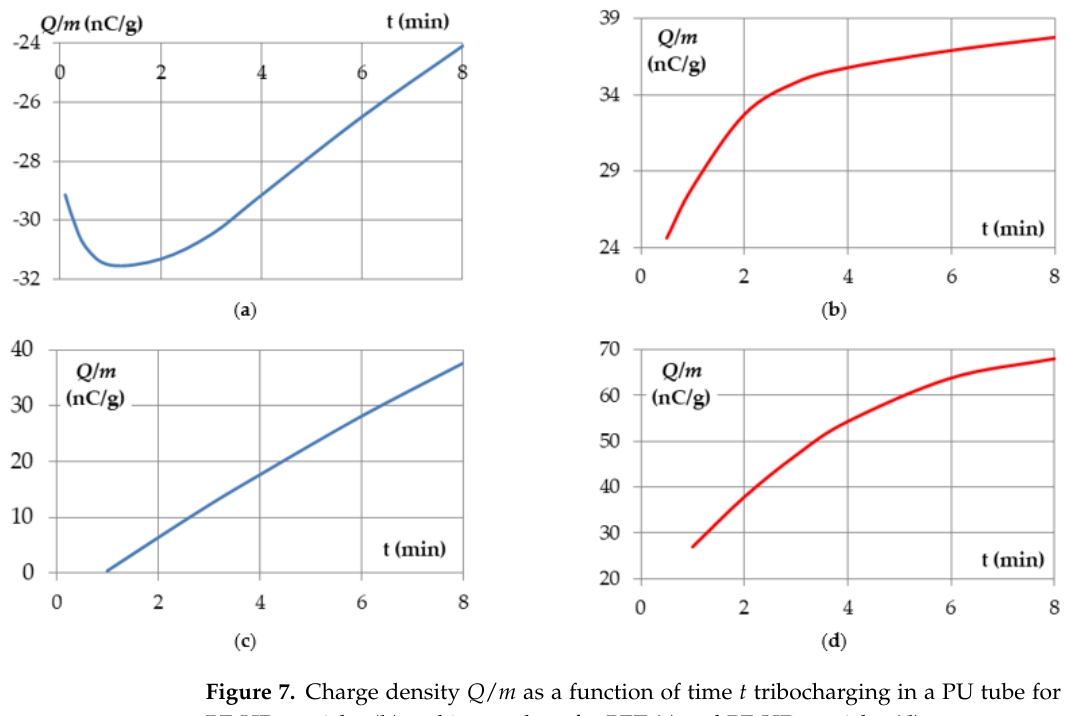
Figure 7. Charge density Q / m as a function of time t tribocharging in a PU tube for PET ( a ) and PE-HD particles ( b ) and in a cyclone for PET ( c ) and PE-HD particles ( d ).